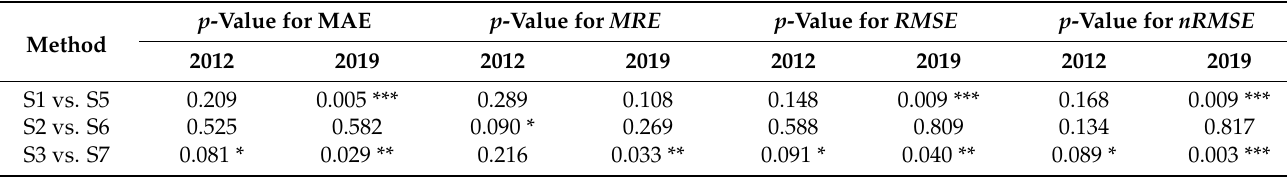
Figure 5. Improved accuracy assessment indexes of three combined machine learning and spatial statistical methods are revealed by comparison with three corresponding machine learning methods. Panels ( a – d ) show the MAE , MRE , RMSE , and nRMSE , respectively; S1 vs. S5 compares S5 with S1, S2 vs. S6 compares S6 with S2, and S3 vs. S7 compares S7 with S3 (S1 = SVM, S2 = RBF-ANN, S3 = RF, S5 = SVM & P-BSHADE, S6 = RBF-ANN & P-BSHADE, S7 = RF & P-BSHADE). Table 3. The prediction indicator differs between the three machine learning methods and the combined methods. A paired t -test was used to examine if the predictive indicators (i.e., MAE and RMSE ) of the combined methods are greater than those of the machine learning method alone based on the results of the 10-fold cross-validation.